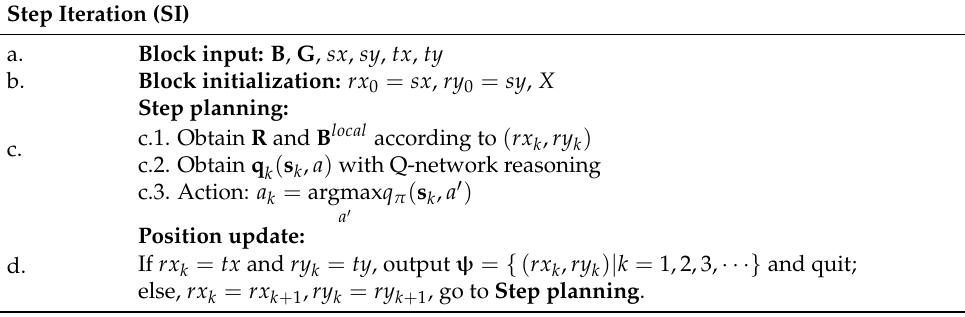
Table 1. The step iteration by the SP-ResNet